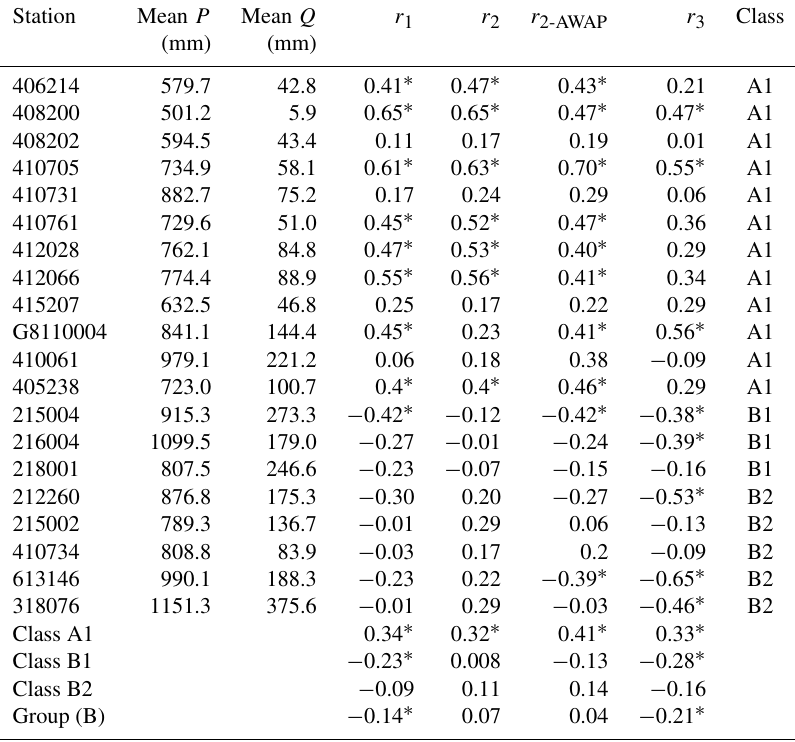
Table 2. Catchment properties and Spearman rank correlations ( r ) for catchments with non-stationary hydrologic response in Australia. Data span the 1984–2010 period. Class categories refer to the catchment classification framework of Fig.